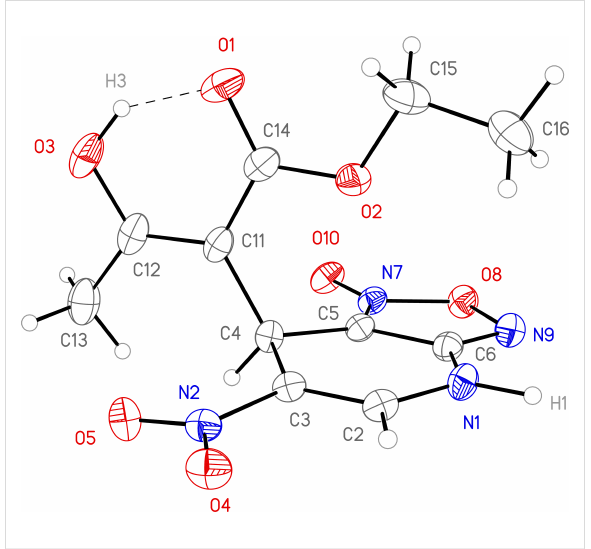
Figure 1: General view of molecule 12 in crystal. Anisotropic displace- ment parameters for non-hydrogen atoms are drawn at 50% probabili- ty; a DMF molecule is omitted for